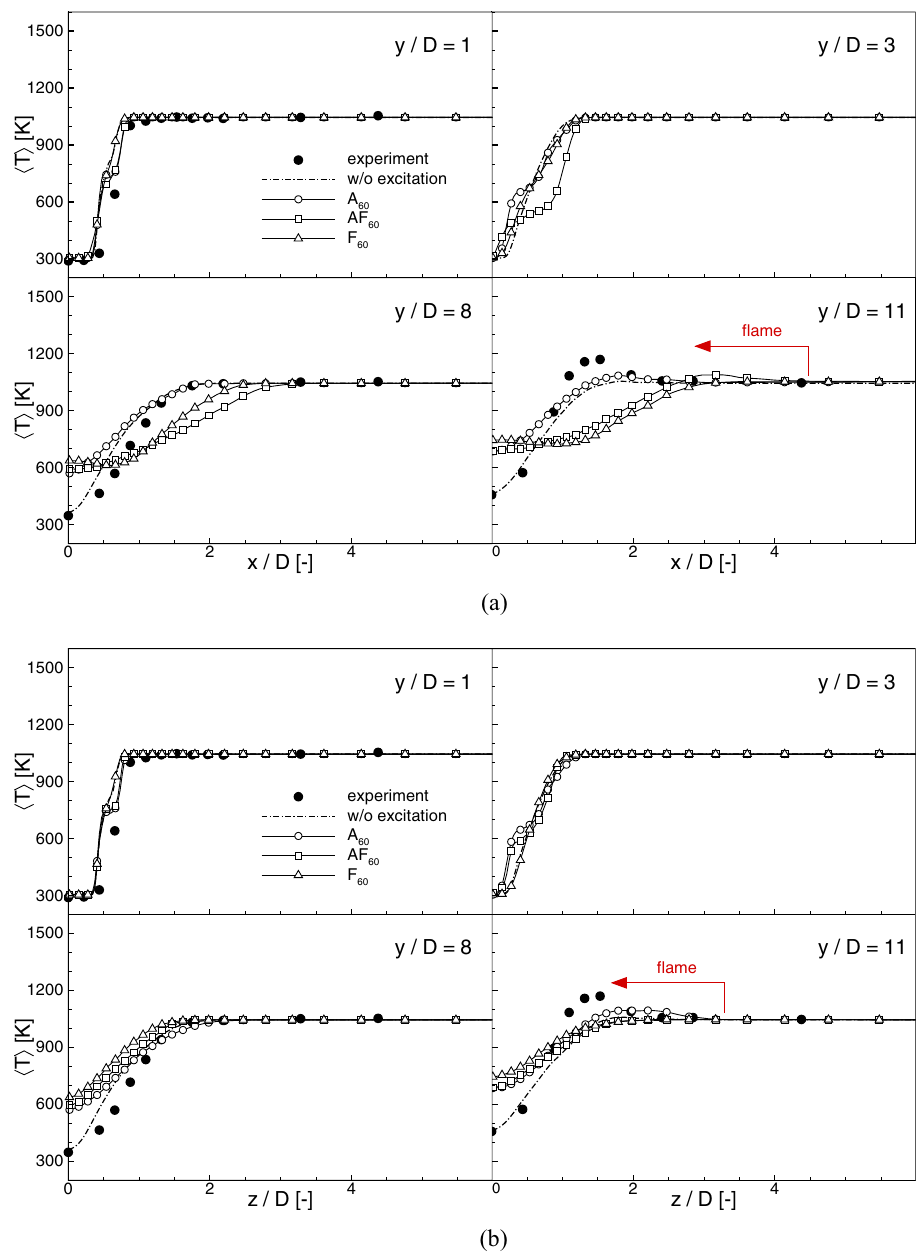
0.60 along the ‘x’-direction ( a ) and the ‘z’-direction ( b =